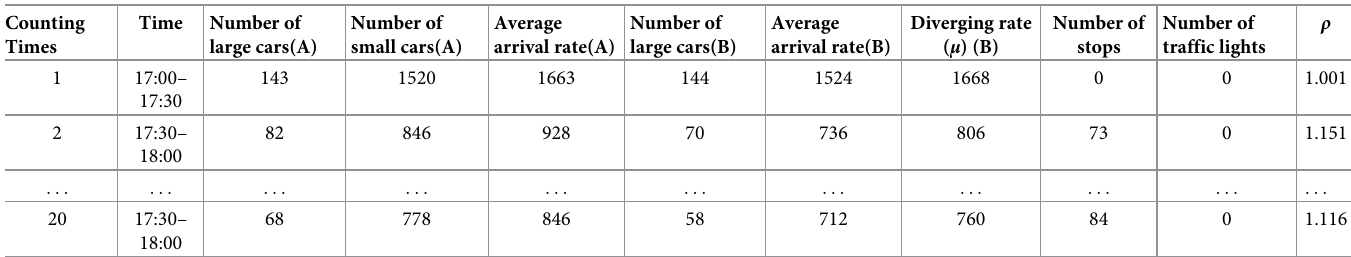
Table 1. The statistics of a road vehicle state.